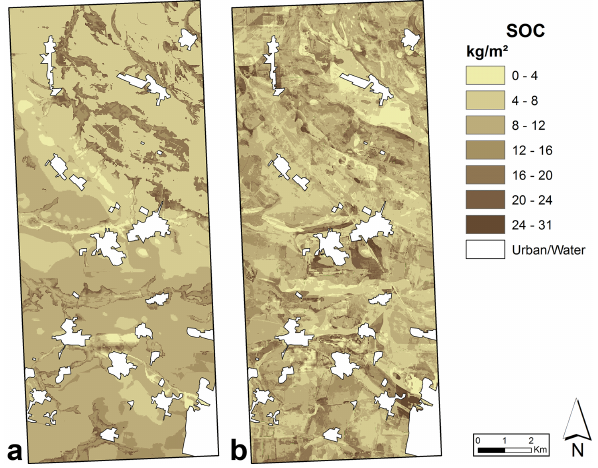
Figure 2. Topsoil SOC stock modelled by (a) the direct approach and (b) the indirect approach. Overlaid on a hillshade to show rela- tionship with relief and field boundaries.